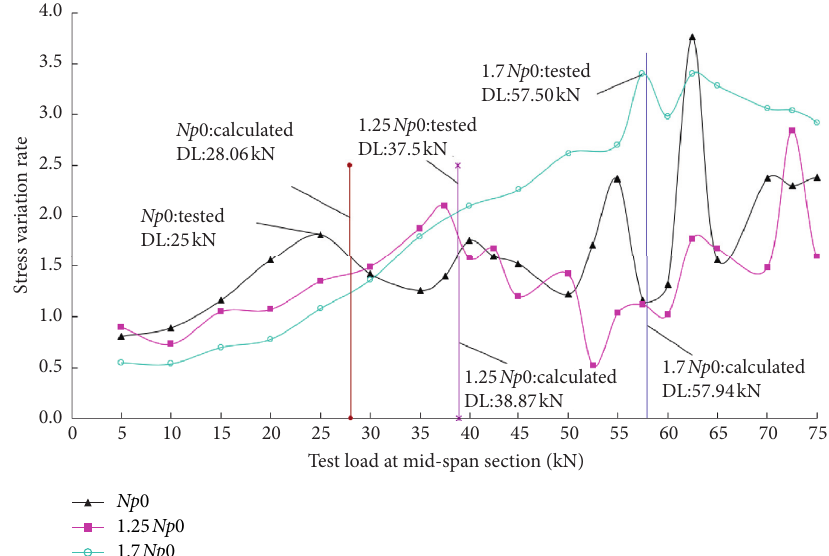
Figure 7: Stress variation rate vs. load curve by the proposed method (by test